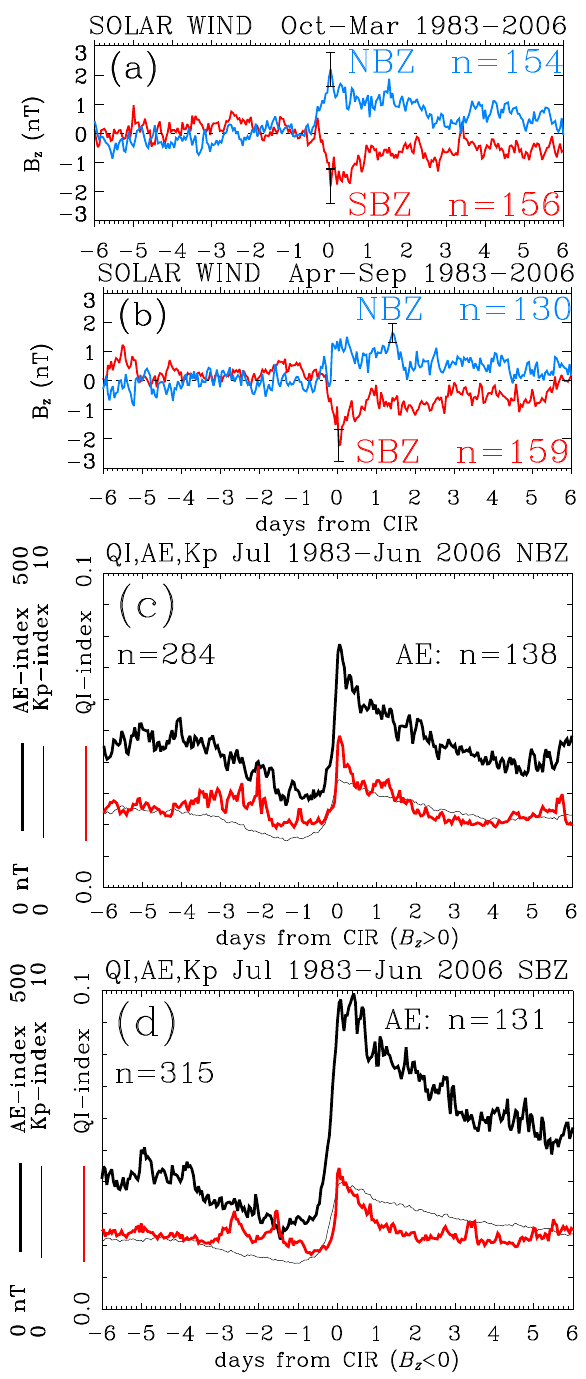
Fig. 11. Superposed epoch analysis of (a–b) the IMF B Z and (c–d) QI, AE and K p indices for NBZ and SBZ events.